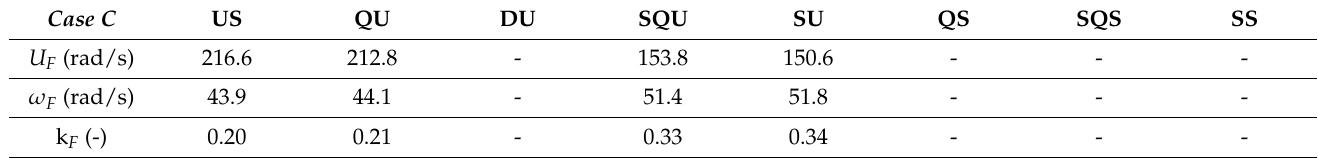
Table 5. Flutter analysis results for Case C using different aerodynamic models; elastic axis at midchord. Case C